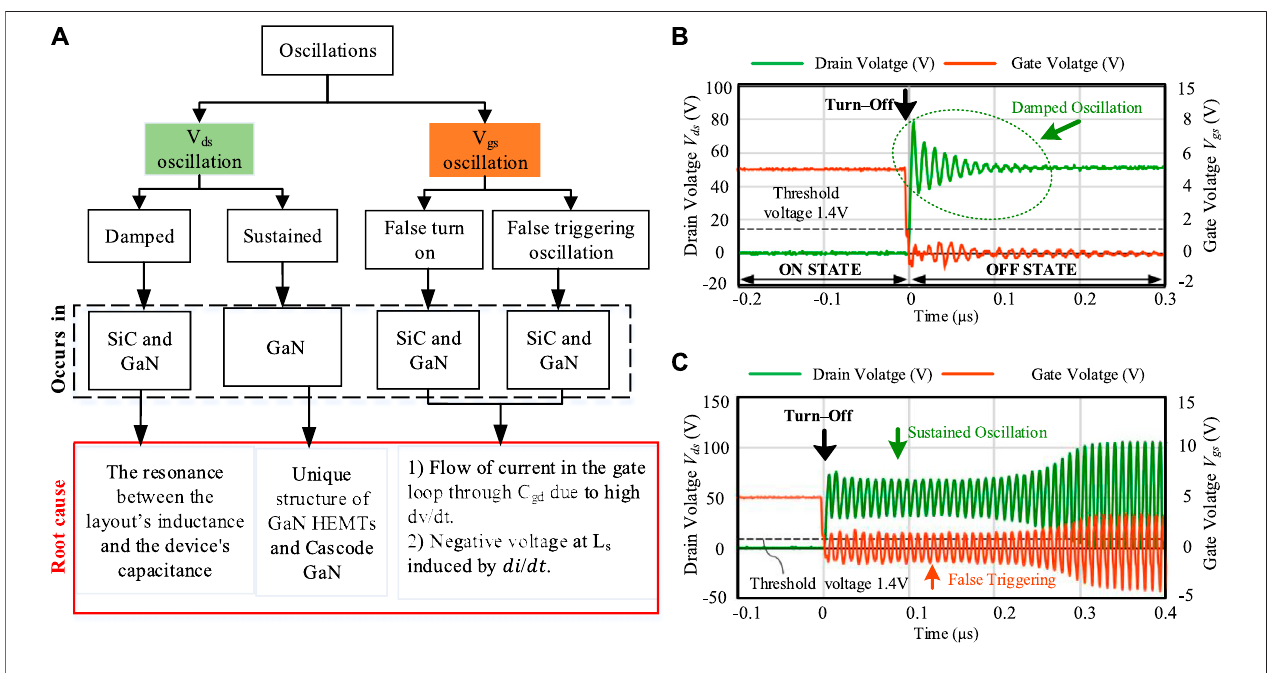
FIGURE 2 | (A) Types of switching oscillations (B) Damped oscillation (C) Sustained oscillation (Umetani et al., 2019).